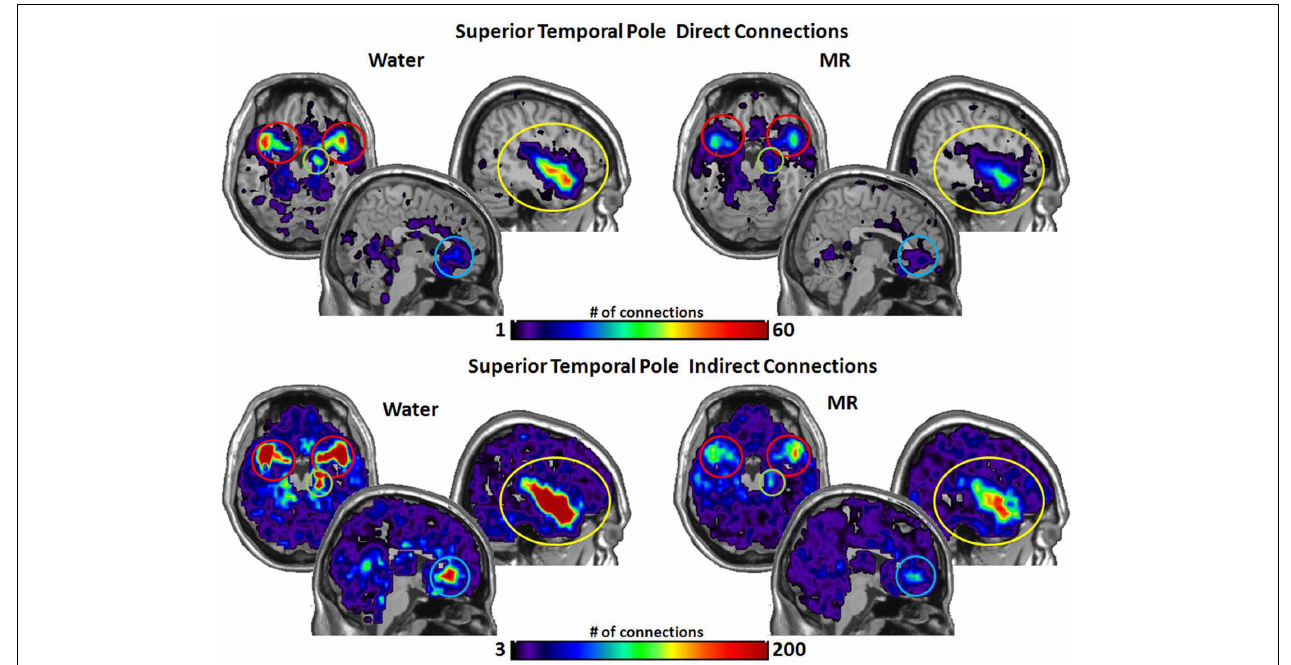
FIGURE 4 | The brain images on the top demonstrate the total number of direct connections from the superior temporal pole (STP) averaged across participants. These images demonstrate that the STP has a greater number of direct connections with the insula and the hippocampus during the water than in the MR condition. The difference in direct connections with the ACC and the amygdala did not reach significance ( p = 0 . 059 and